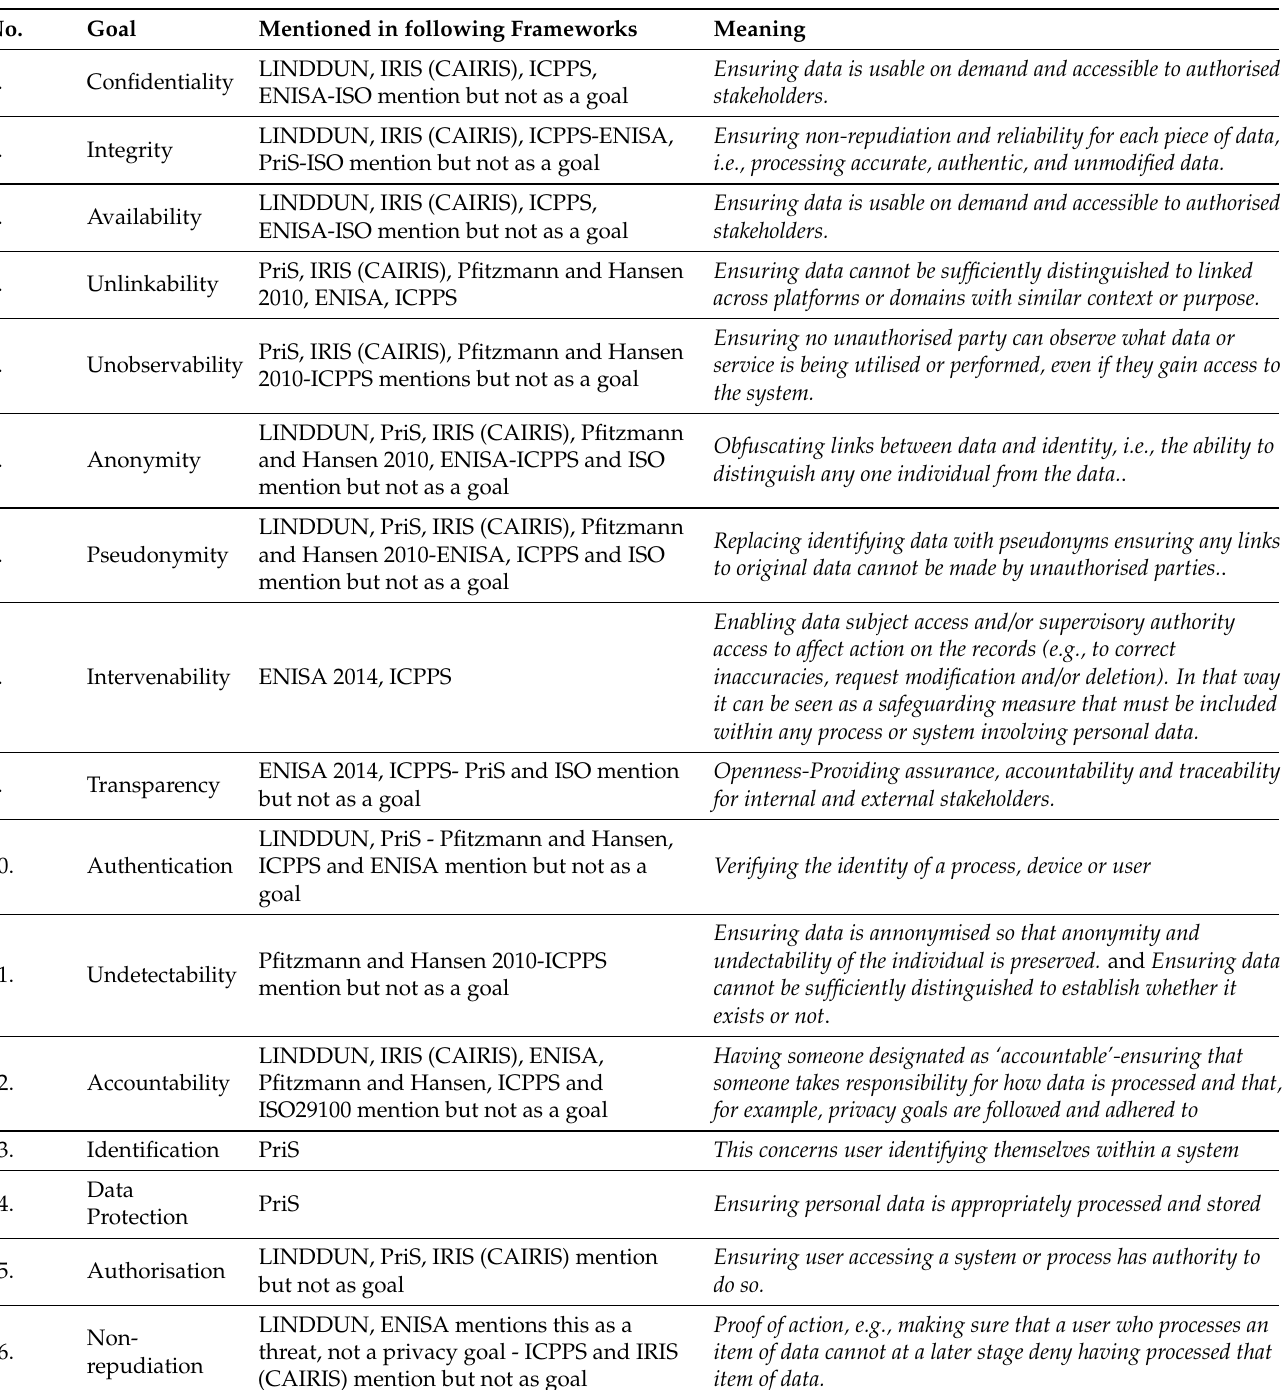
Table 1. Privacy Goals Compared incl.